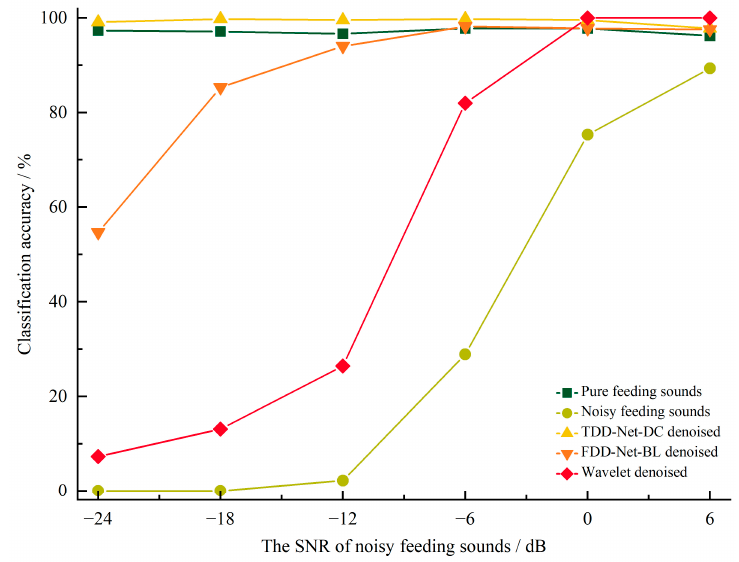
Figure 9. Comparison of classification accuracy for the feeding sounds before and after denoising.